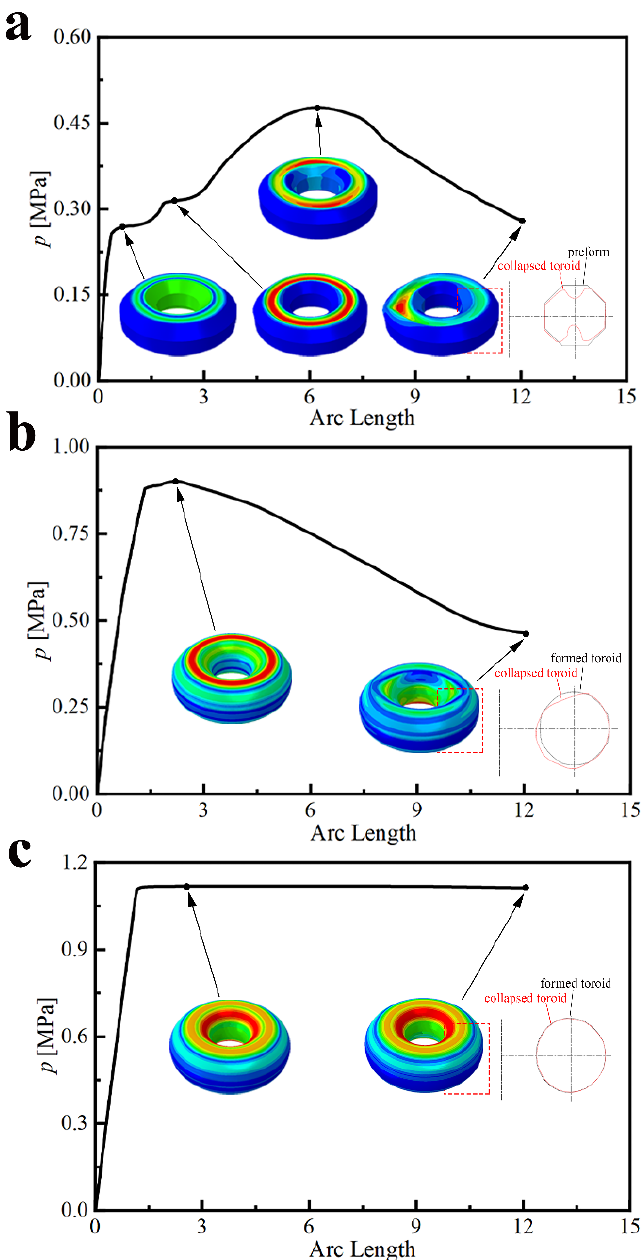
Figure 10. Applied pressure–arc length curves of toroidal pressure hulls under hydroforming pressures of 0 MPa ( a ), 3 MPa ( b ), and 5 MPa ( c ), along with several representative deformed geometries. Zero hydroforming pressure corresponds to discrete octagonal cross-sections before hydroforming in Figure 1.